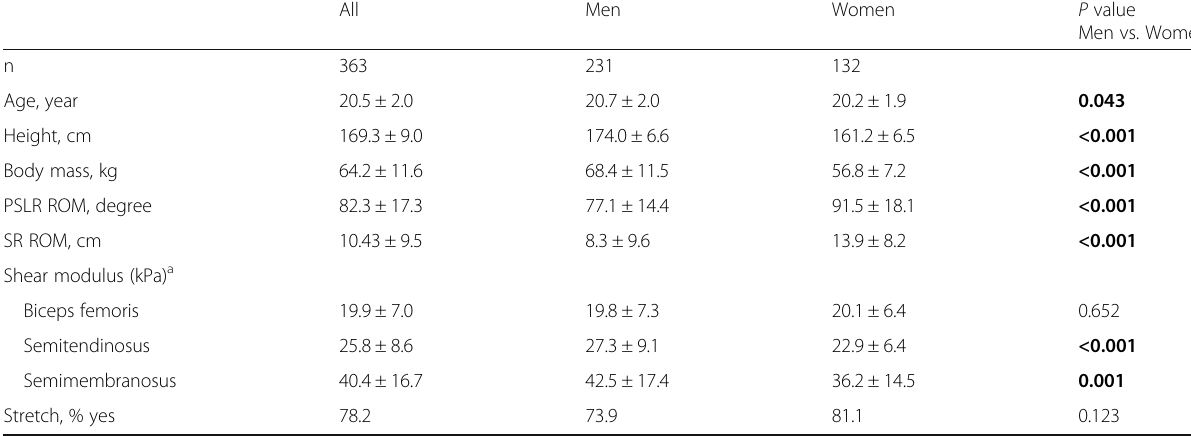
Table 1 Participant characteristics in Study 1 ( n =